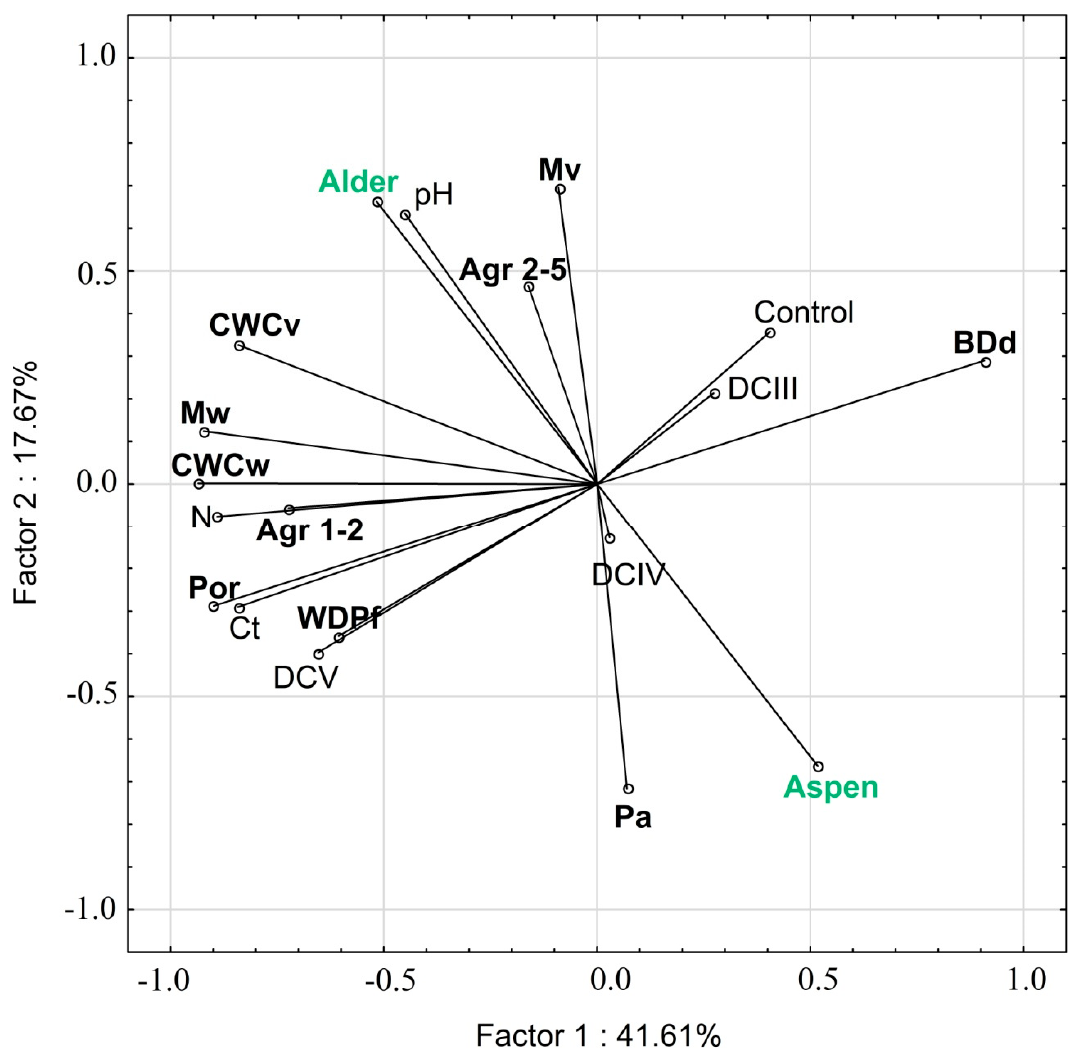
Figure 1. Diagram of principal component analysis (PCA) with projection of variables on a plane of the first and second factor for soil (Ct—total carbon content, N—nitrogen content, Por—porosity,